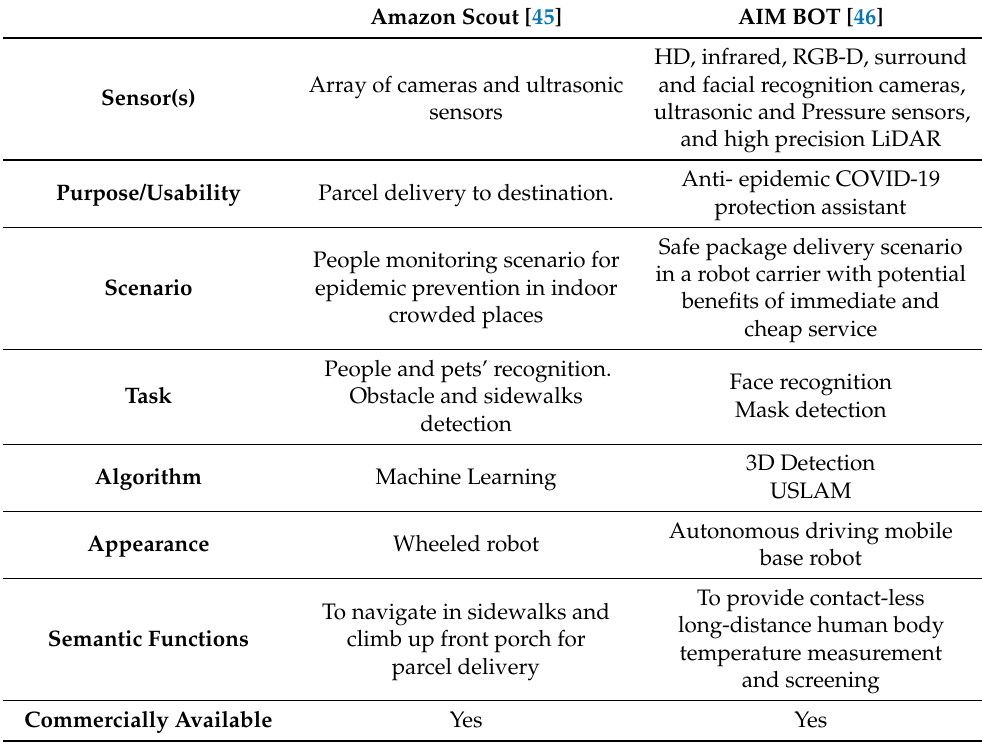
Table 3. Robots in Public